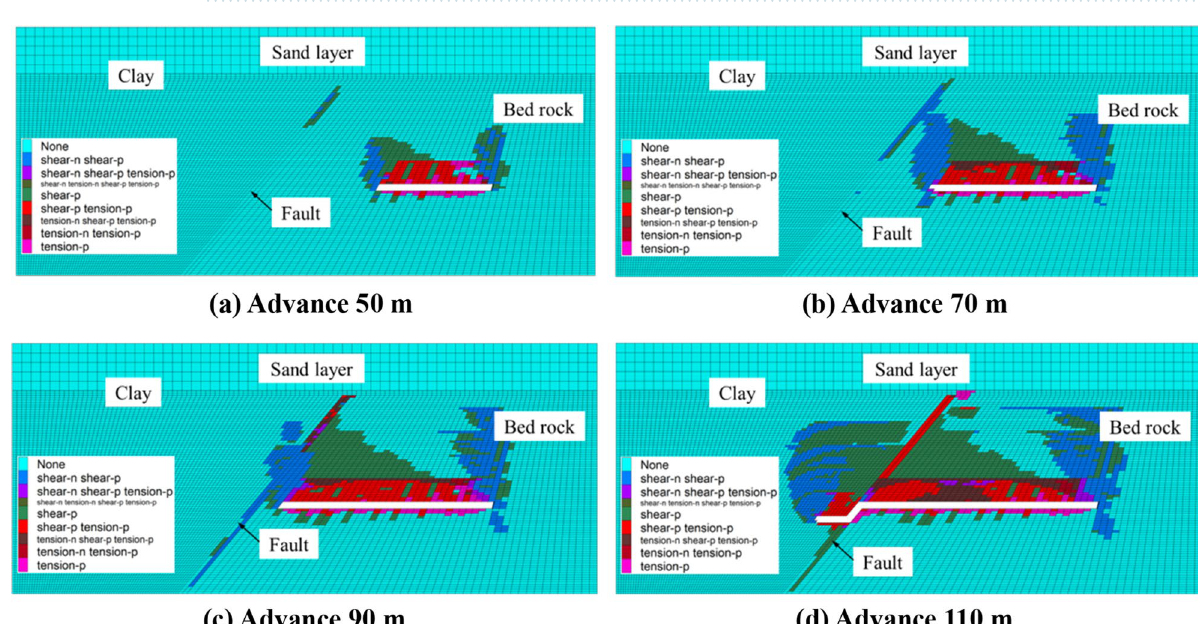
Figure 6. Plastic failure diagram of the model for a bedrock thickness of 40